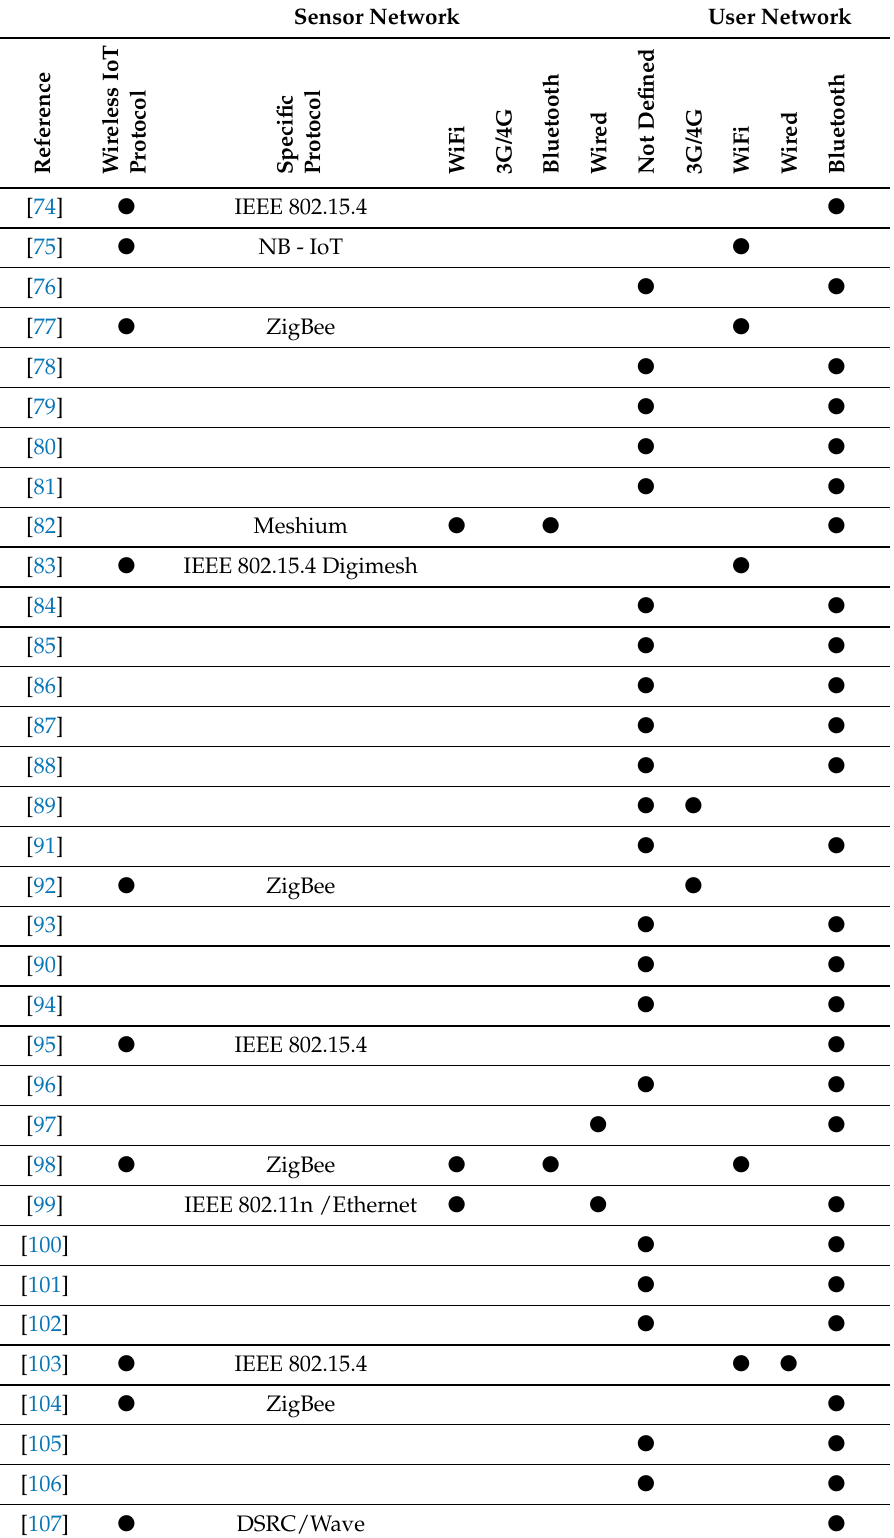
Table 5. Cont . Sensor Network User